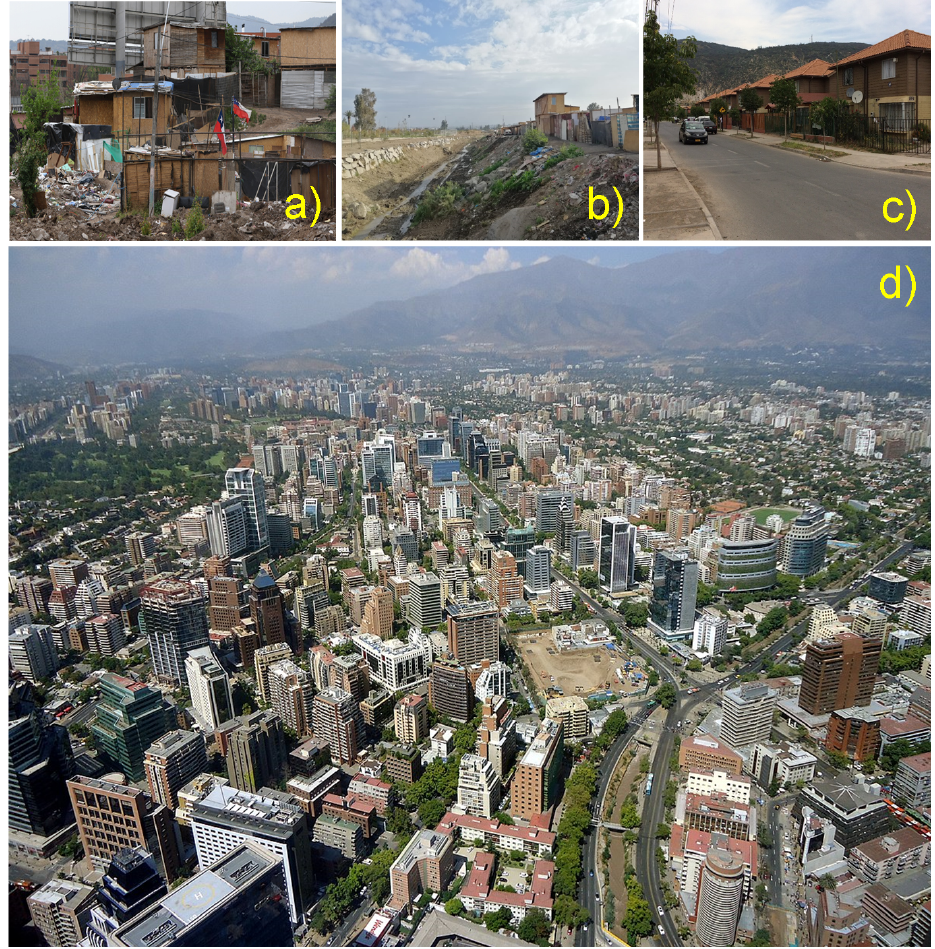
Figure 2. Different urban scenarios in Chile. ( a , b ) A typical camp and poor area in the periphery of a city (picture extracted from [41,42]), ( c ) a typical middle-class neighbourhood (picture extracted from [43]) and ( d ) a high-income district in the east-side of the capital. The panoramic view shows the financial district of the capital, also known as “Sanhattan” (picture extracted from